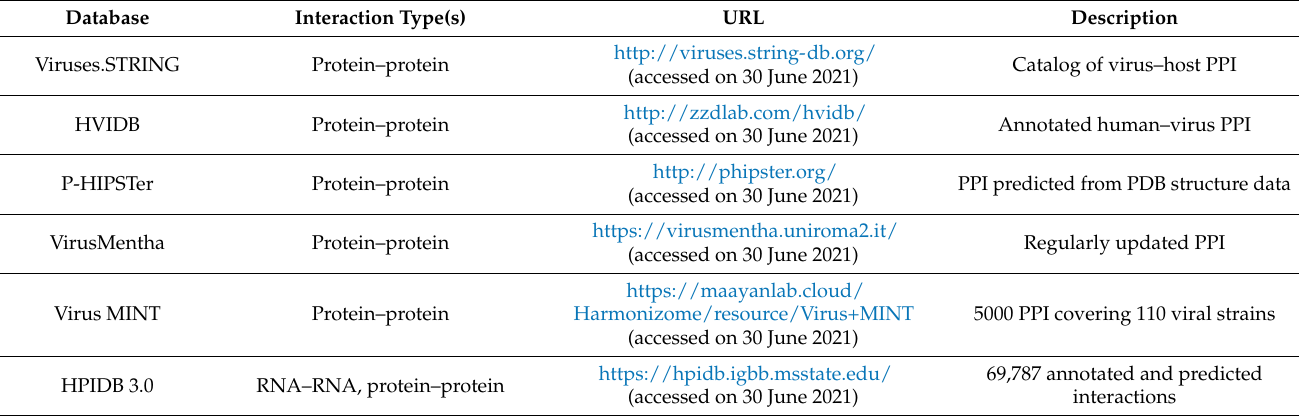
Table 3. General resources and databases with viral HPI data. These databases were last accessed in June